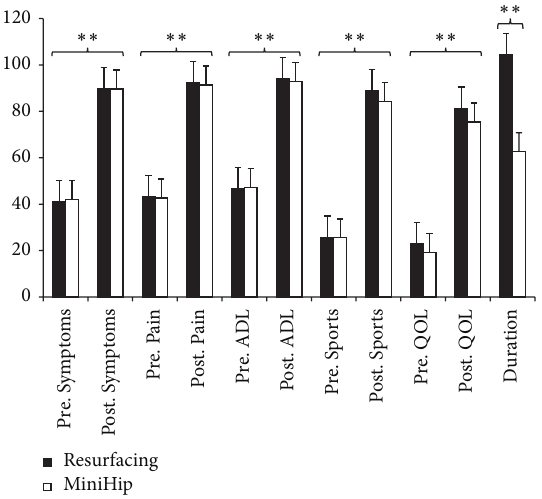
Figure 2: Comparison of presurgery and postsurgery HOOS (scale of 0–100) means (and standard error) and duration of surgery (in minutes) in MiniHip and resurfacing arthroplasty. Independent of surgery type, all subscale scores improved after surgery. The only group differences were found in comparison of surgery duration. ∗∗ 𝑝 < 0.0001